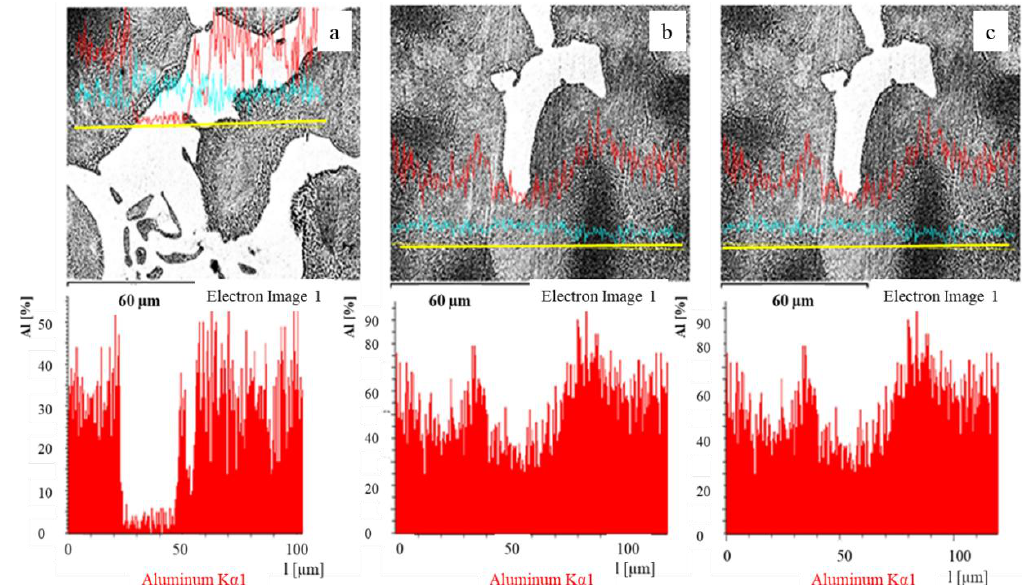
Figure 3. EDS analysis results and the variation of the concentration of the Al in the ZnAl22 alloy cast with steel die for three ( a – c ) different areas.